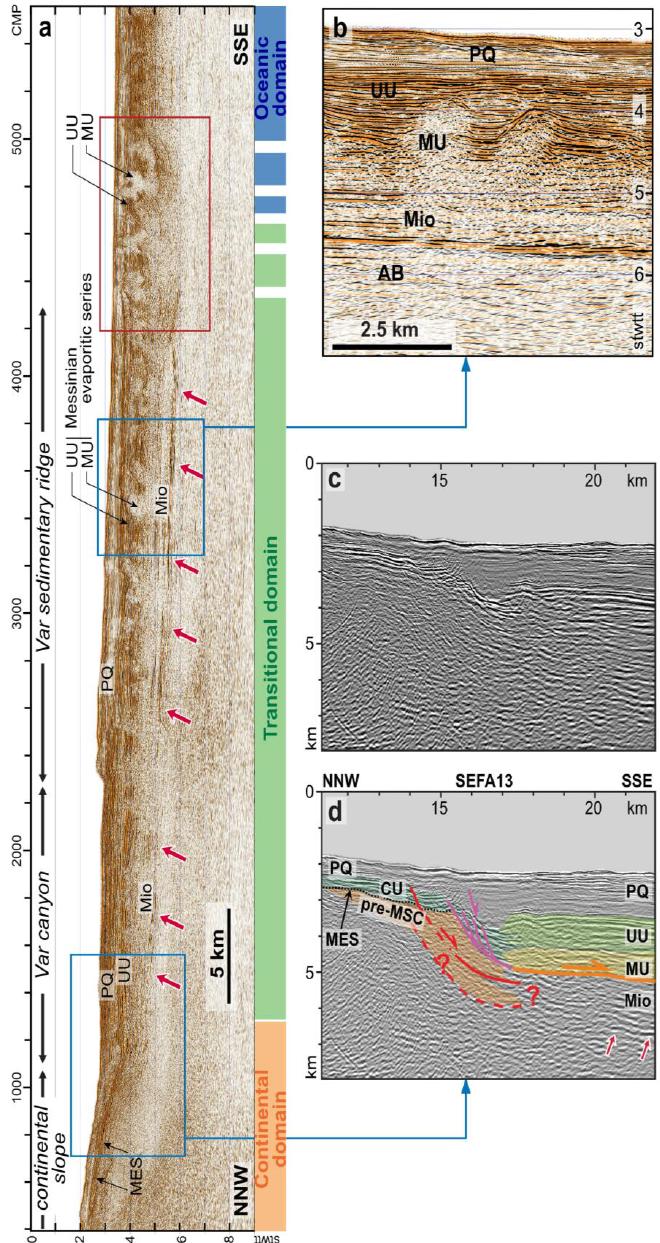
Figure 5. ( a ) Part of the prestack time migration of profile SEFA13 (see Figure 3 for location) from the deep continental slope (North) to the middle of the basin (South); stwtt: seconds two-way travel time. Four morphostructural domains (continental slope, Var canyon, Var ridge, and deep basin) are identified from bathymetry and seismic facies; PQ: Plio-quaternary, UU/MU: Upper/Mobile Units, MES: Messinian Erosional Surface/Detritic Messinian Units, Mio: Miocene (pre-Messinian). Red arrows point to the top of the acoustic basement. Extent of basement domains [10] are indicated. Blue frames refer to close-ups shown in ( b ), ( c ), and ( d ); red one refers to a zone discussed in the text. ( b ) Close-up on main seismic facies identified in the mid-part of the SEFA13 profile (framed in a); notations as in ( a ); AB: Acoustic Basement. ( c ), ( d ) Part of the pre-stack depth migration of profile SEFA13 at the deep continental slope (framed in ( a ): ( c ) uninterpreted; and ( d ) interpreted. CU: Messinian clastic unit, pre-MSC: pre-Messinian unit; the base of the Messinian salt (MU) is underlined in orange, pink faults are related to salt tectonics; note the convex up geometry of the Messinian markers on the margin and the deep rooting level of the red fault(s) (see text for